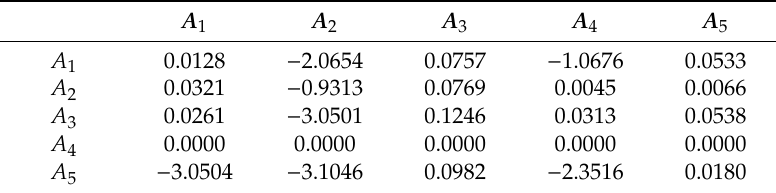
Table 18. Relative prospect dominance ϕ 4 .